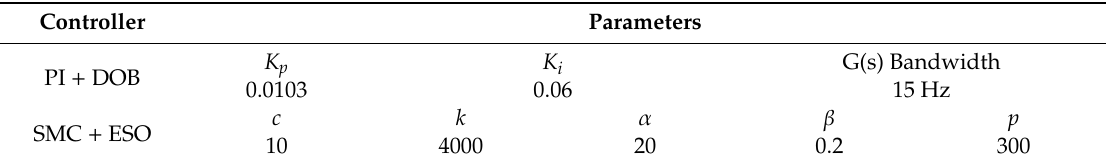
Table 4. Controller